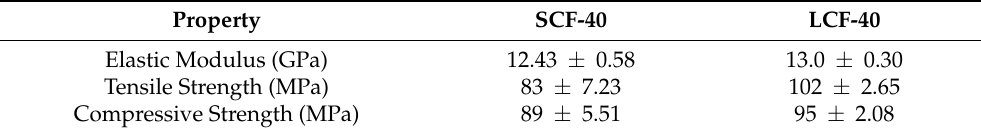
Table 2. Monotonic tensile test results at 120 ◦ C for the injection-moulded materials with standard deviation reported as plus